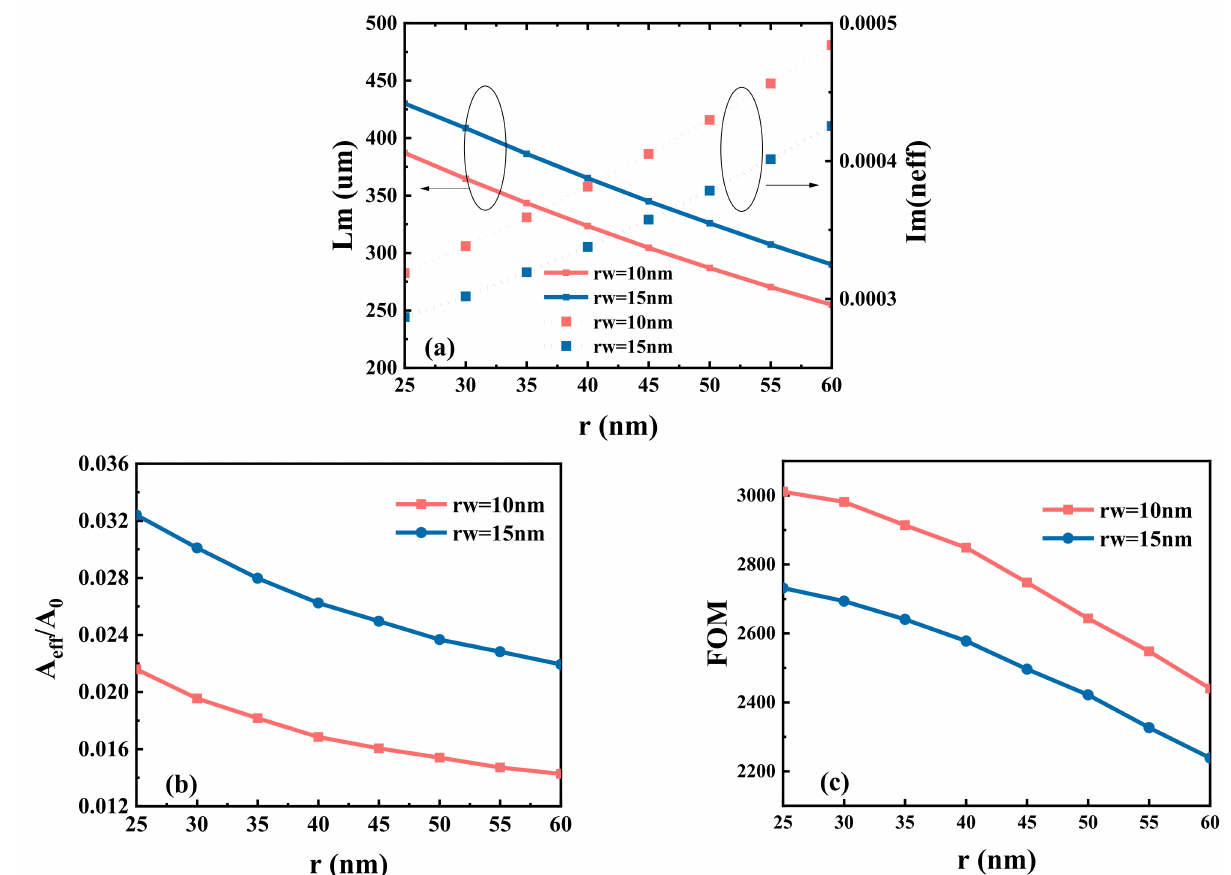
Figure 2. Dependence of modal properties on the radius of Si waveguide r for different curvature radius rw : ( a ) propagation length L m ; ( b ) normalized effective mode area A ef f / A 0 ; and ( c ) figure of merit FOM . Here, h = 15 nm, α = 60 ◦